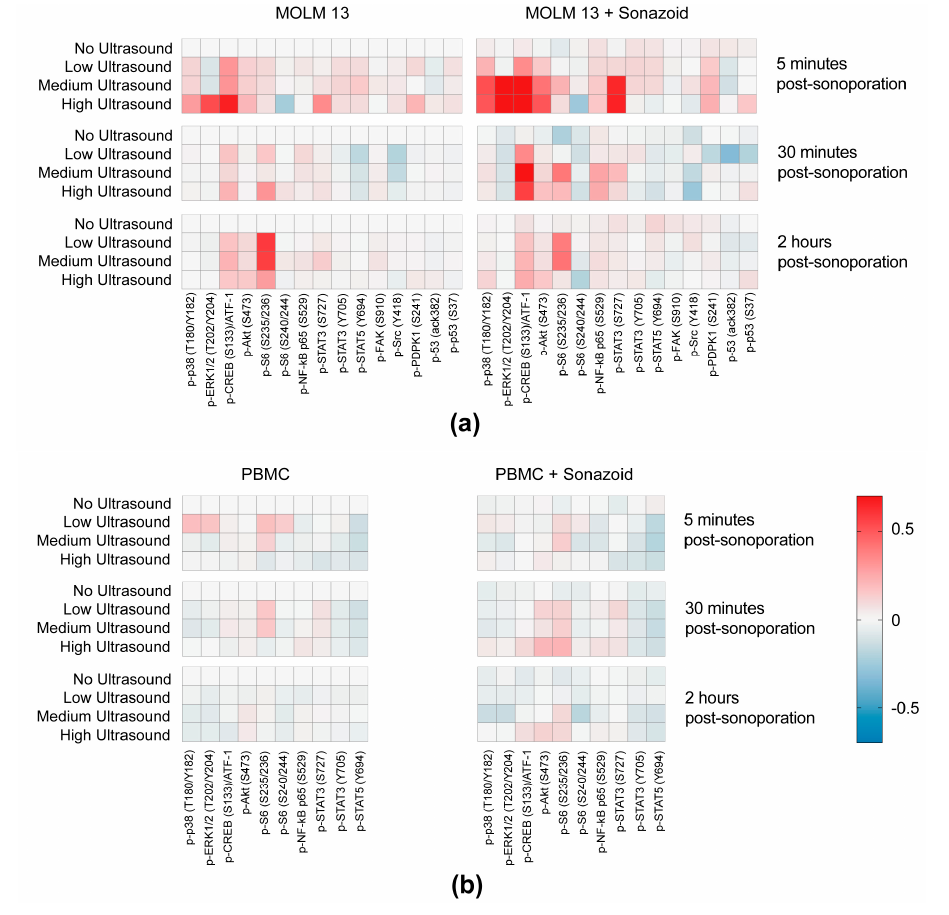
Figure 5. Intracellular signaling profiles of sonoporated cells. ( a ) Heatmaps displaying changes in phosphorylation status in MOLM-13 of the chosen range of proteins in response to treatment with ultrasound with and without Sonazoid TM microbubbles. Phosphorylation status was detected 5 min, 30 min and 2 h post sonoporation (mean of Arcsinh ratios) ( b ) Heatmaps displaying changes in phosphorylation status in PBMC of the chosen range of proteins in response to treatment with ultrasound with and without Sonazoid TM microbubbles. Phosphorylation status was detected 5 min, 30 min and 2 h post sonoporation (mean of Arcsinh ratios).